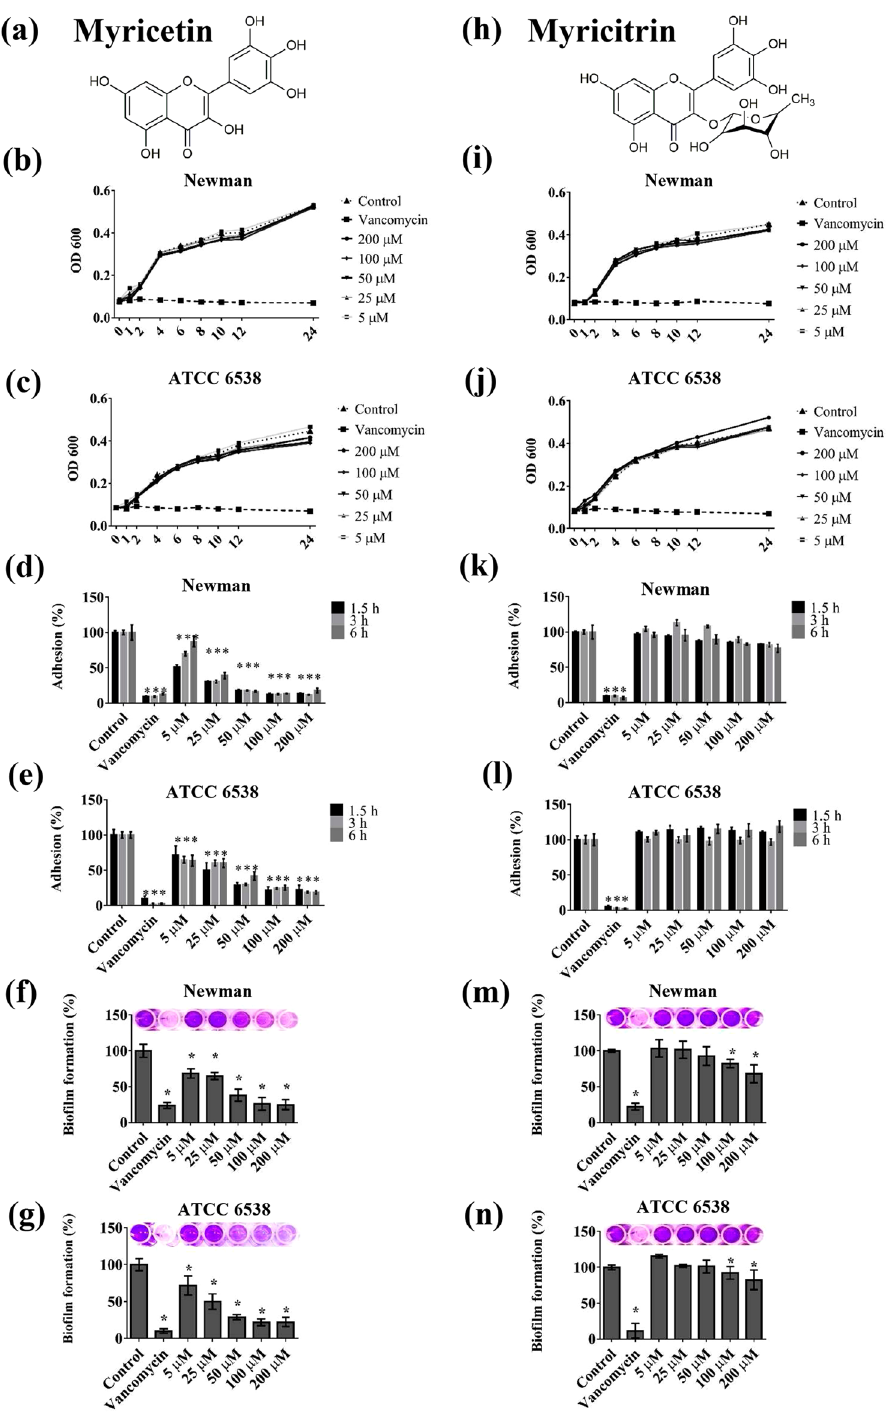
Figure 1. Effects of Myricetin (Myr) and Myricitrin (Myr-gly) on S. aureus growth, initial adhesion and biofilm formation. ( a ) Chemical structure of the Myr consisting of 3-hydroxyflavone backbone and 6 hydroxyl groups. ( b , c ) Growth kinetics at different concentrations of Myr (0, 5, 25, 50, 100 and 200 µ M) during 24 h against S. aureus Newman and ATCC 6538. ( d , e ) Initial adherence of S. aureus Newman and ATCC 6538 treated with Myr during 1.5, 3 and 6 h. ( f , g ) Dose-response curve of biofilm formation tested against S. aureus Newman and ATCC 6538 in the presence of Myr. ( h ) Chemical structure of the flavonol Myr-gly, corresponding to derivative 3-O-rhamnoside of myricetin. ( i , j ) Growth kinetics at different concentrations of Myr-gly (0, 5, 25, 50, 100 and 200 µ M) during 24 h against S. aureus Newman and ATCC 6538. ( k , l ) Initial adherence of S. aureus Newman and ATCC 6538 treated with Myr-gly during 1:30, 3 and 6 h. ( m , n ) Dose-response curve of biofilm formation tested against S. aureus Newman and ATCC 6538 in the presence of Myr-gly. * Represents statistically significant differences ( p -value < 0.01) in relation to the control samples. Photos of crystal violet assay: increasing violet color indicates higher biofilm